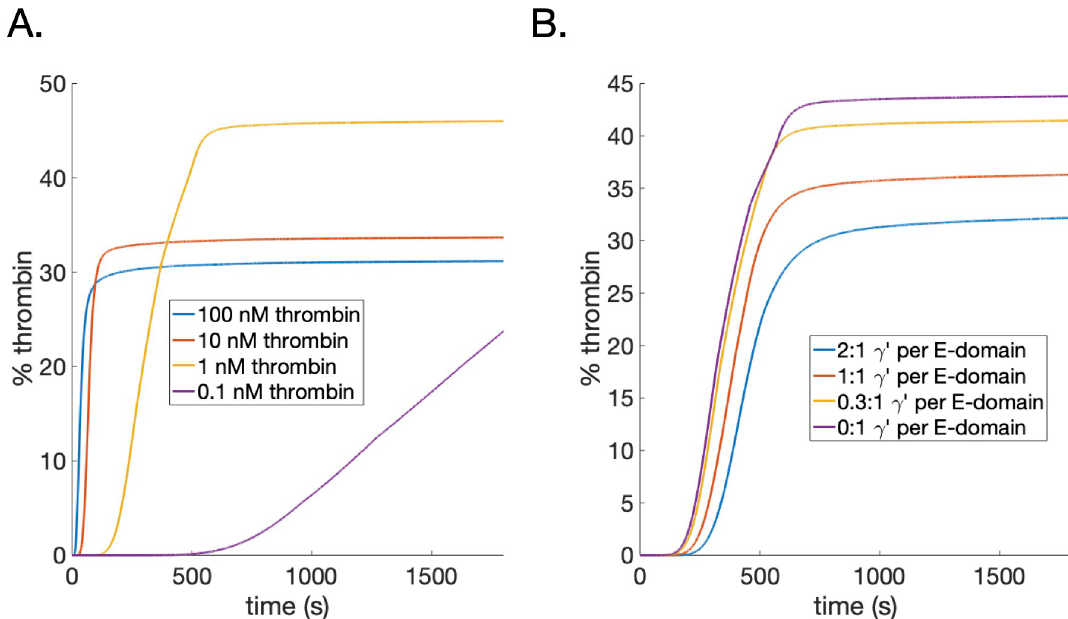
Fig 8. Estimates of percent of bound thrombin that is trapped within fibers as a function of increasing: A) thrombin (0.1 nM —purple, 1.0 nM —yellow, 10 nM —red,100 nM —blue) and B) the ratio γ 0 binding sites to fibrin(ogen) monomers (0:1—purple, 0.3:1—yellow, 1:1—red, and 2:1—blue). As thrombin is increased, percent of thrombin trapped decreases following the protofibril number, with the exception of the 0.1 nM where enough time has not elapsed for it to surpass the yellow curve. As the γ 0 ratio increases, the trapped thrombin monotonically